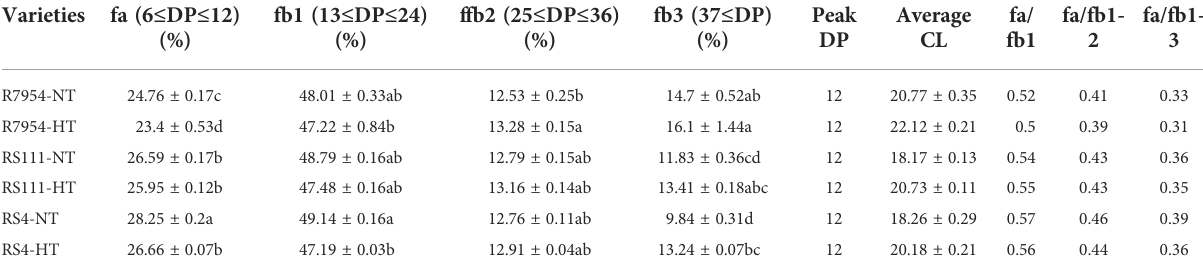
TABLE 2 Chain length distribution of amylopectin in all rice materials, as determined by HPAEC-PAD analysis*. Varieties fa (6 ≤ DP ≤ 12)